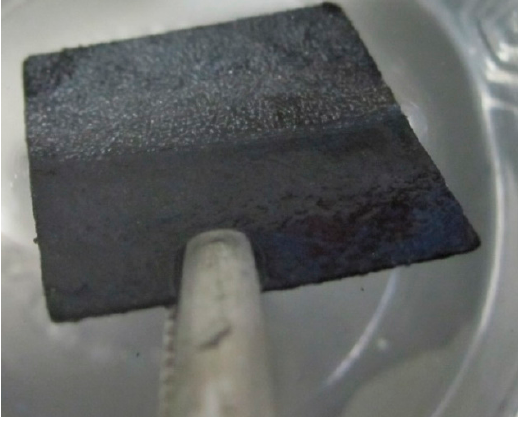
Figure 2. Carbon paper electrode with air bubbles after pre-treatment.